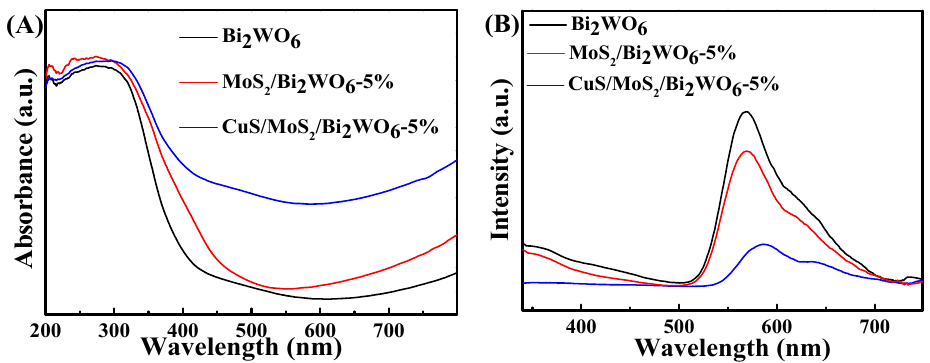
Figure 4. ( A ) UV–Vis absorbance spectra and ( B ) photoluminescence spectra of Bi 2 WO 6 , MoS 2 /Bi 2 WO 6 -5%, and CuS/MoS 2 /Bi 2 WO 6 -5%.